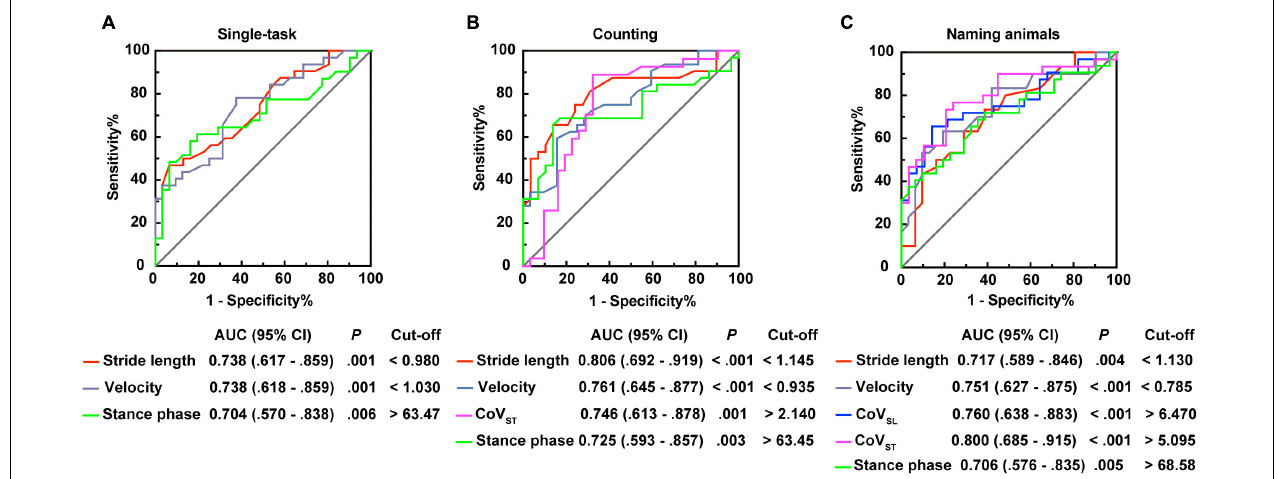
FIGURE 3 | Receiver operating characteristic curve analysis (ROC) plots for gait characteristics identifying the individuals with post-stroke dementia (PSD) from individuals with post-stroke non-dementia (PSND). (A) Stride length, velocity, and percentages of the stance phase for identifying patients with PSD in the single-task gait test. (B) Stride length, velocity, CoV ST , and percentages of the stance phase for distinguishing patients with PSD in the counting backward-task gait test. (C) Stride length, velocity, CoV SL , CoV ST , and percentages of the stance phase for distinguishing patients with PSD in the naming animals-task gait test. AUC, area under the curve; CI, confidence interval; cut-off, cut-off point; CoV, coefficient of